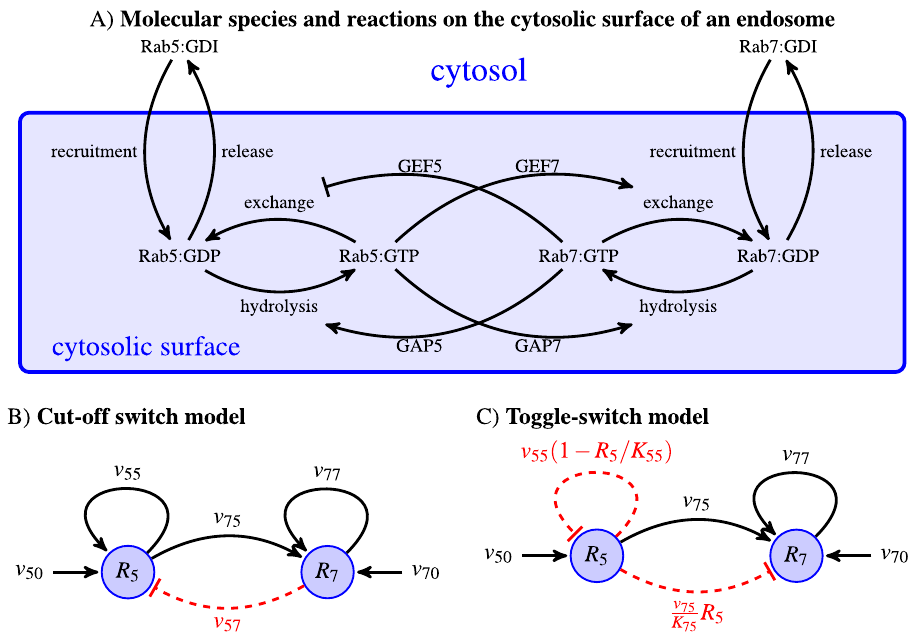
Figure 1. Schematic summary of the biochemical reactions which take place on the cytosolic surface of an endosome and competing hypotheses for Rab5 and Rab7 activation. ( A ) Biochemical reactions that regulate the levels of Rab5 and Rab7 in the cytosol and on the surface of endosomes in inactive (Rab-GDP) and active (Rab-GTP) forms. GDI means GDP-dissociation inhibitor (see Ref. 21,23 for details). Eqs. (12) and (13) (or Eqs. (14) and (15)) encode the key molecular interactions considered in each mathematical model. ( B ) Cut-off switch model of Rab5 to Rab7 switching. For instance, the red dashed line is modelled by the term proportional to v 57 x 7 . ( C ) Toggle-switch model of Rab5 to Rab7 switching. The increase of Rab7 with time is caused by a reduction of the activation signal due to an inhibitory one. The level of active Rab5 ( R 5 ) decreases with time due to a negative feedback of the active Rab7 ( R 7 ). Both models have been adapted from Ref. 21 . The rates v ij will be encoded in the molecular current, (cid:31) J , defined in Eqs. (12) and (13) for the cut-off switch model, and Eqs. (14) and (15) for the toggle-switch